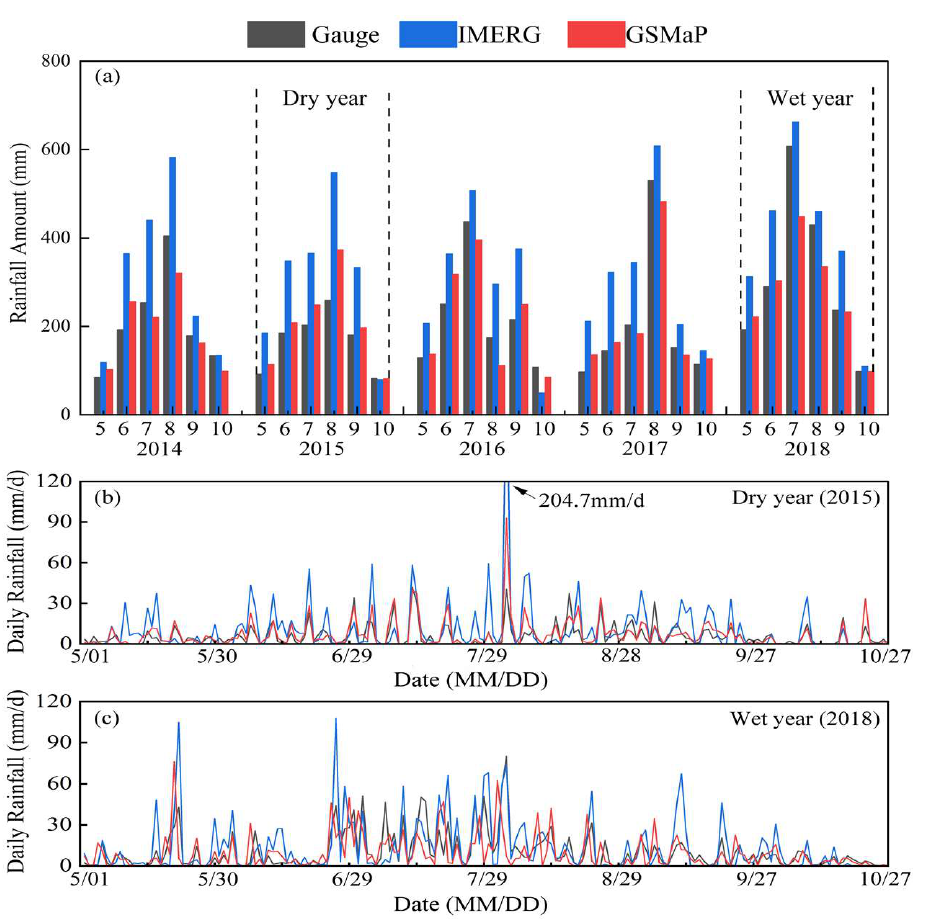
Figure 2. ( a ) Variation of rainfall amount of gauge and satellite products from 2014 to 2018. Temporal distribution of daily rainfall over the driest ( b ) and wettest ( c )